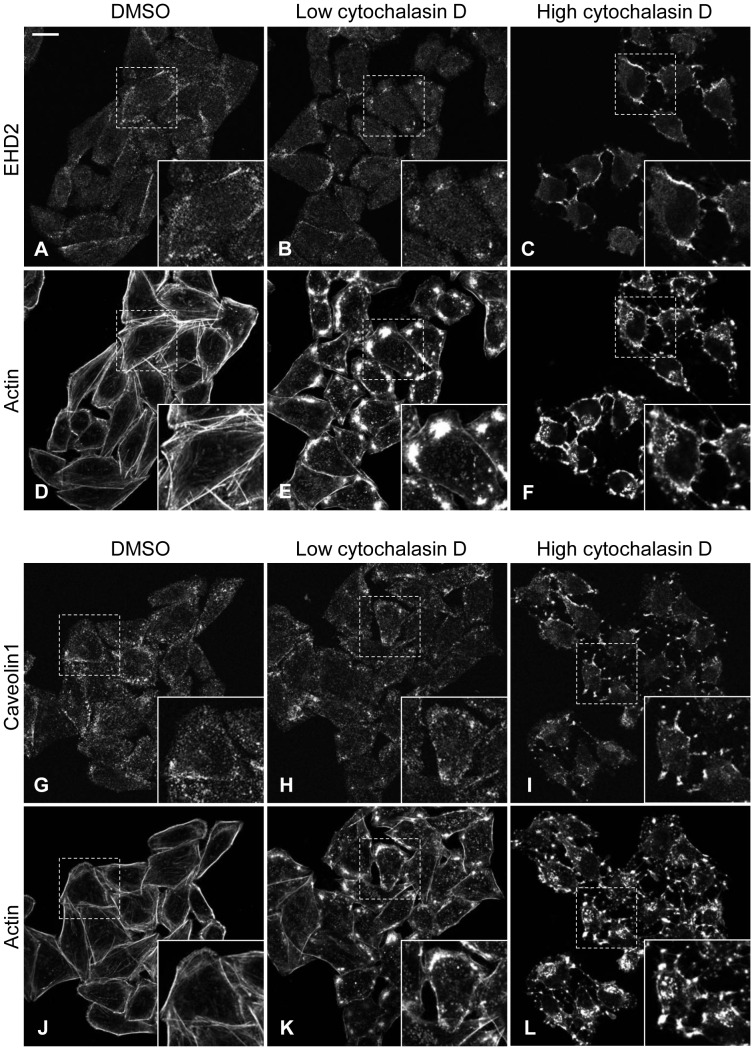
EHD2 and caveolin1 localization to the plasma membrane is independent of intact actin microfilaments.HeLa cells growing on coverslips were treated with DMSO, or with a low (0.3 µM) or high (5 µM) concentration of cytochalasin D for 45 min. The cells were then fixed and stained with antibodies against EHD2 (A–C) or caveolin1 (G–I) along with phaolloidin-488 to visualize actin (D–F, J–L). After incubation with fluorochrome-conjugated secondary antibody, the cells were analyzed by confocal microscopy. Insets depict the regions in the dashed boxes. Bar, 10 µm. The confocal micrographs are representative of three independent experiments with 0.3 µM cytochalasin D, and two independent experiments with 5 µM cytochalasin D.